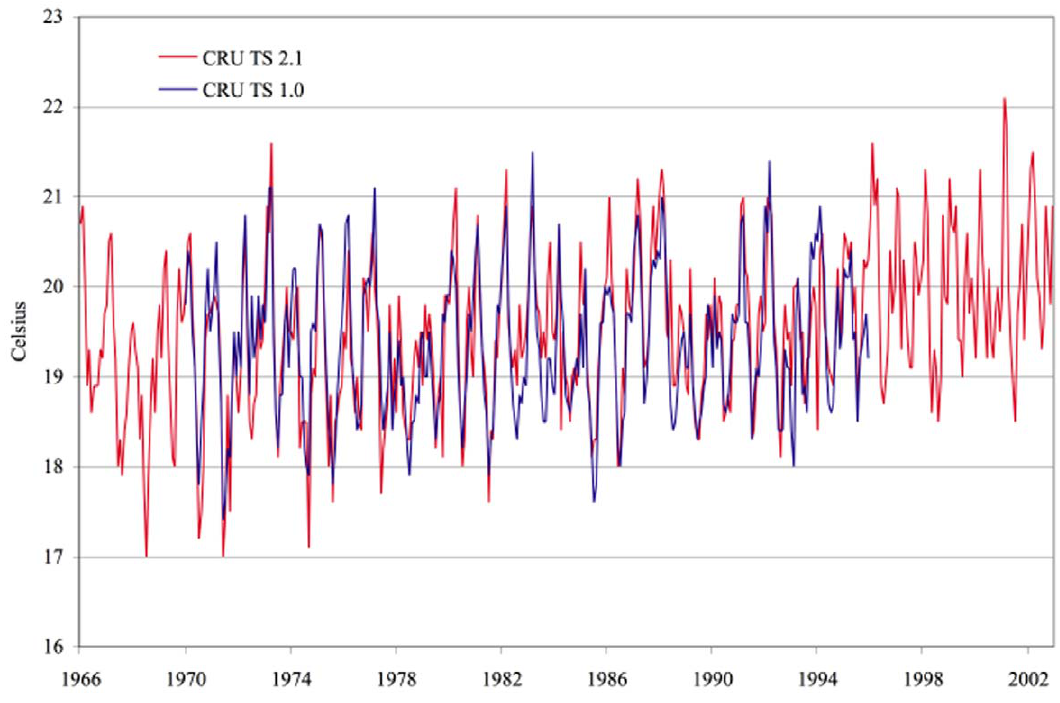
Figure 2. Temperature series for Kericho: CRU TS 1.0 vs. CRU TS 2.1.